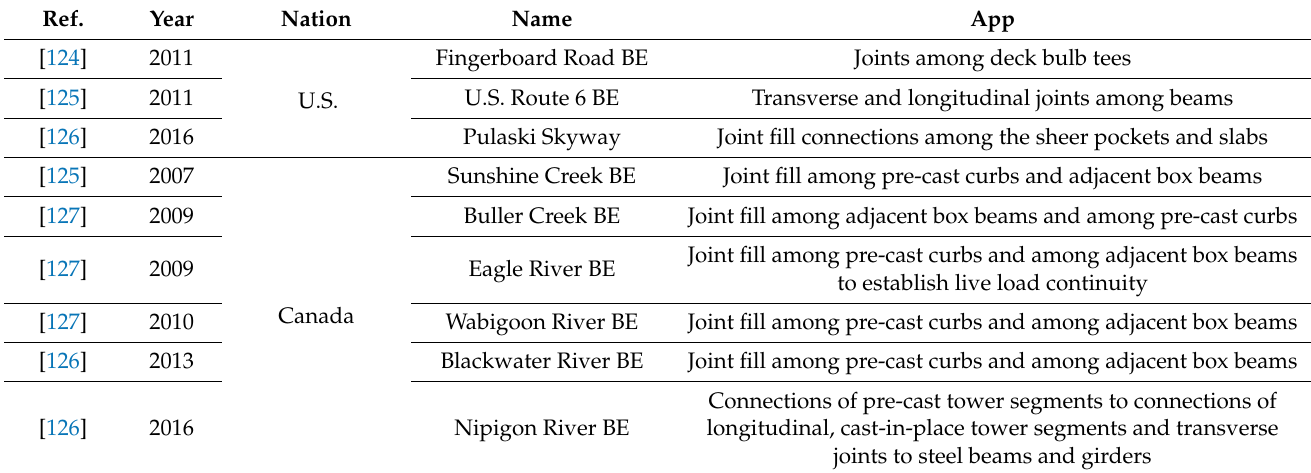
Table 5. Applications of ultra-high-performance concrete in BE joints.